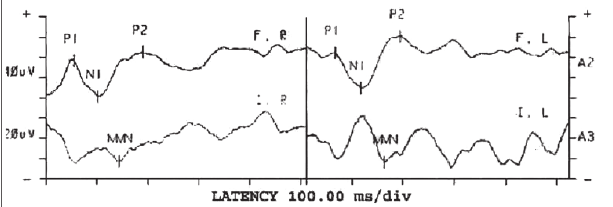
Figura 1. Resultado do exame MMN - ms - milissegundos P1/N1/P2